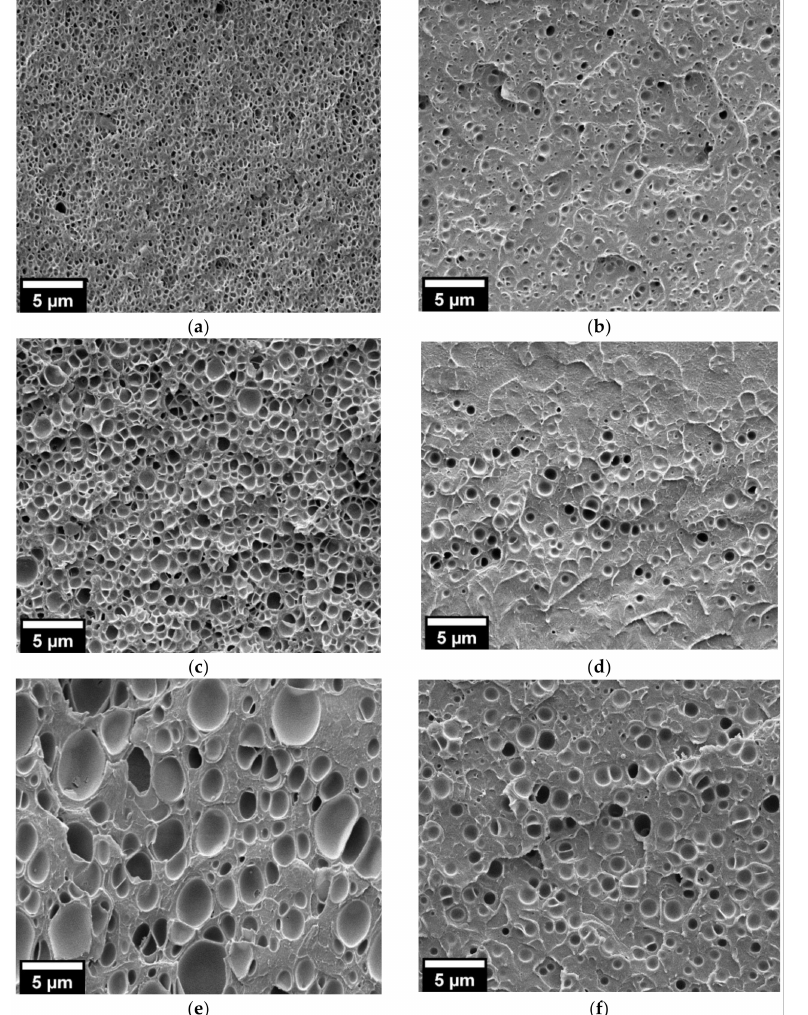
Figure 2. HRSEM micrographs of the cellular structure of the neat PMMA foams obtained from bulk samples (left) and films (right) at 30 MPa and different saturation temperatures ( a , b ) 40 ◦ C; ( c , d ) 50 ◦ C; ( e , f ) 60 ◦